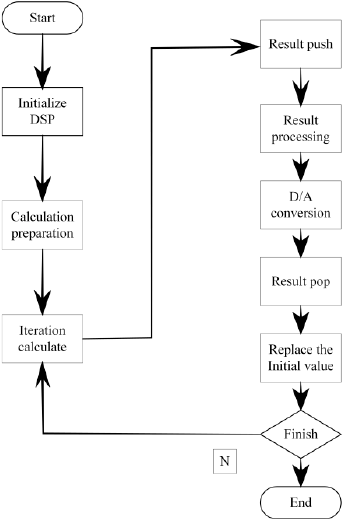
Figure 10. Programming flow of DSP implementation.